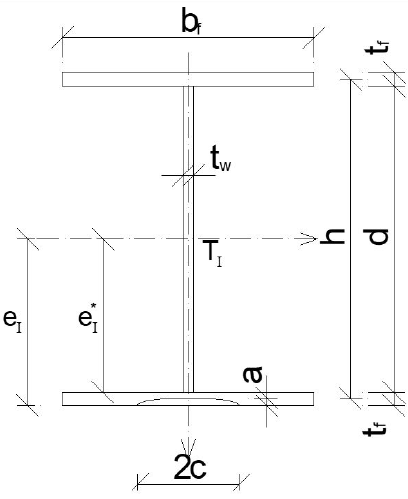
Figure 3. Cross-sectional characteristics of biaxially symmetric